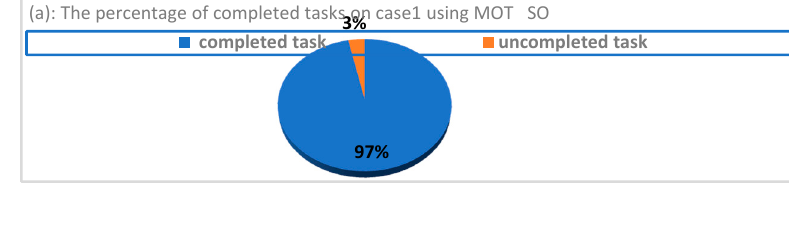
Table 10. The result of the total travel costs (TTCs) using our MOTSO